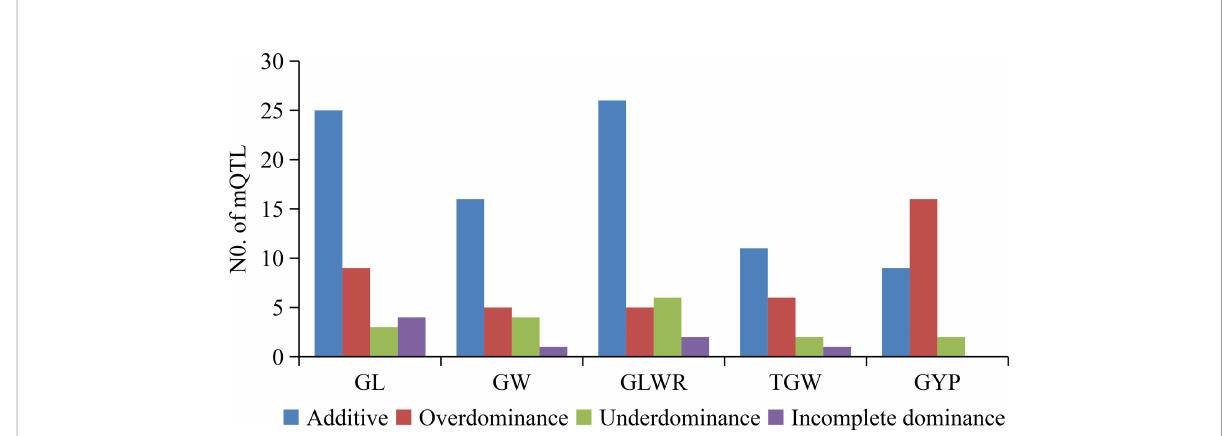
FIGURE 2 Numbers of mQTL classi fi ed by gene action for grain shape and grain weight as well as grain yield traits detected in RILs, BC 1 F 1 s, and H MP s. GL, grain length; GW, grain width; GLWR, grain length-width ratio; TGW, 1000-grain weight; GYP, grain yield per